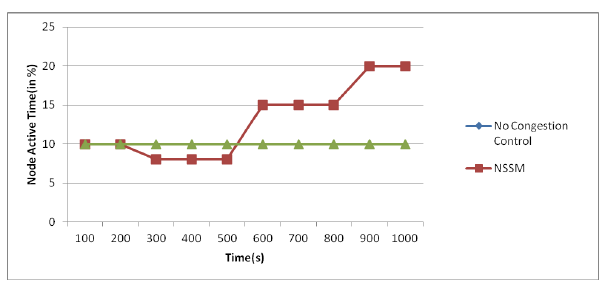
Figure 5. Change in Active time for node A